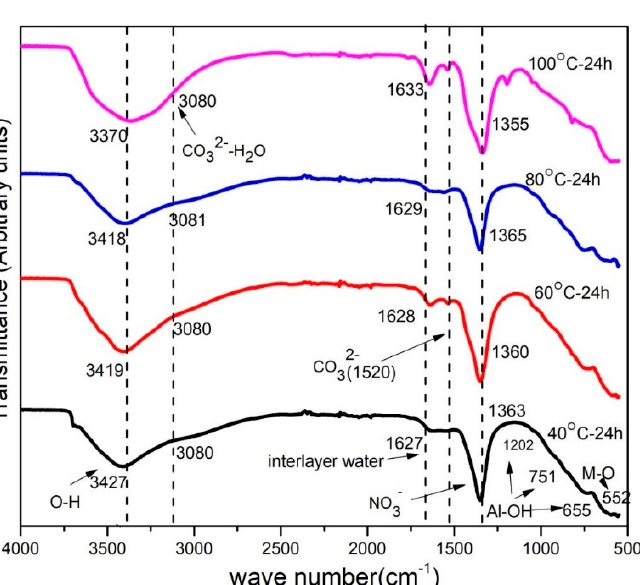
Figure 3. ATR-FTIR spectra of Mg–Al LDH powder, scraped from as-prepared MgAl–LDH coated